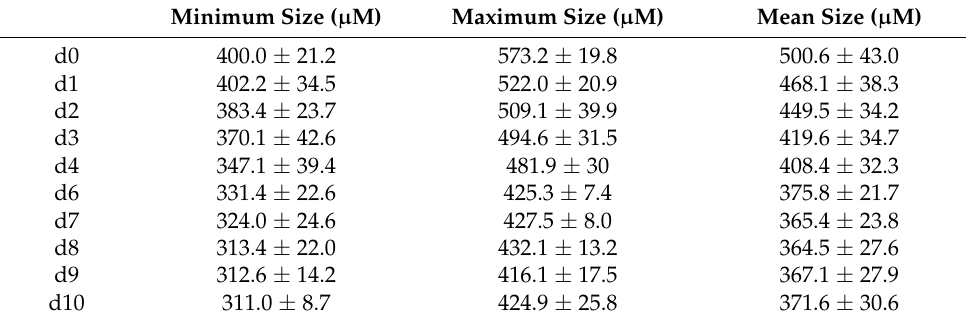
Table 1. Minimum, maximum and mean size of 34 spheroids population for each day.